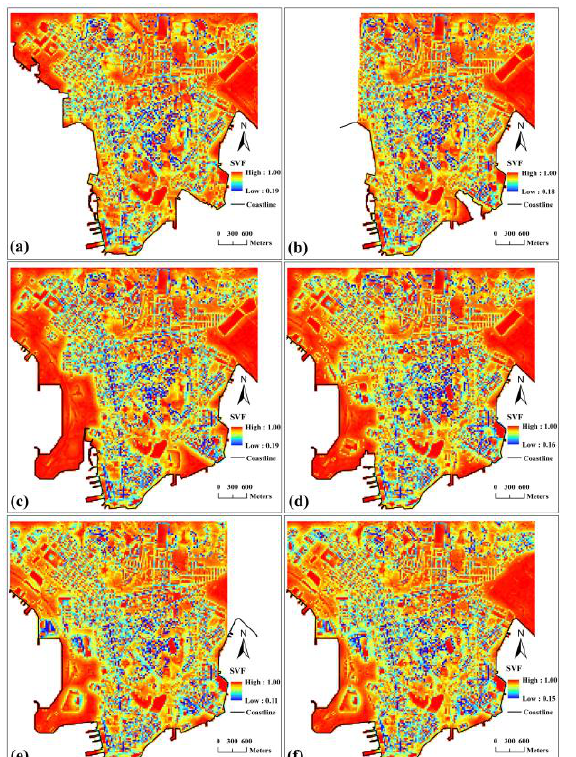
Figure 4. The parameter setting window of the FAI